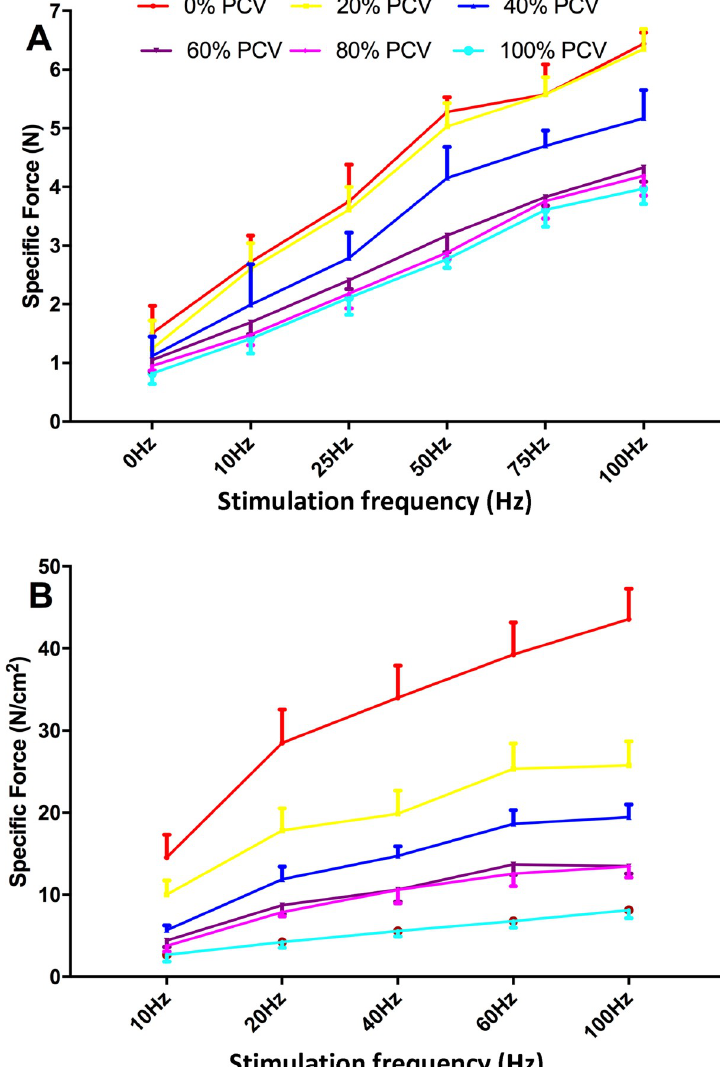
Fig 3. In vivo (A) and in vitro (B) muscle tonus after 24-h controlled mechanical ventilation at different intensities under different frequencies of electric stimulation.